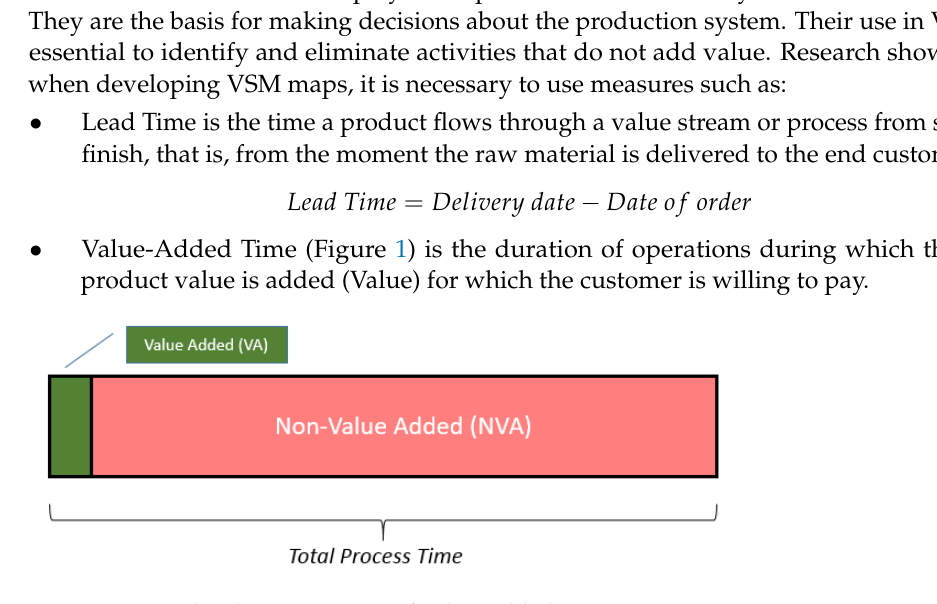
Figure 1. A graphical representation of Value-Added Time.